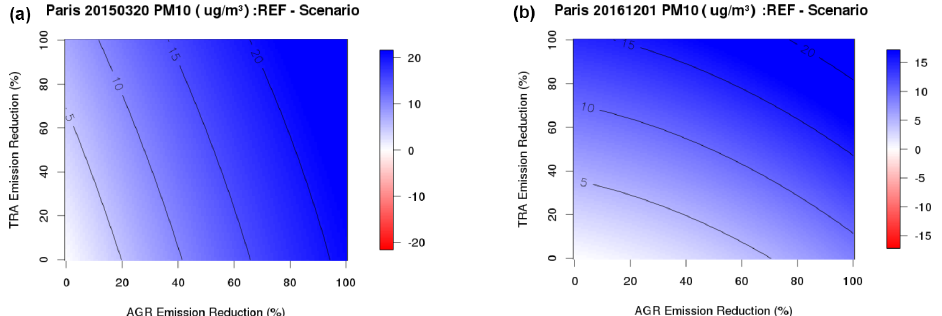
Figure 16. PM 10 concentration reduction (positive for a decrease in blue) corresponding to a given reduction in traffic and agriculture emissions over the Paris area – daily average for 20 March 2015 (a) and 1 December 2016 (b)